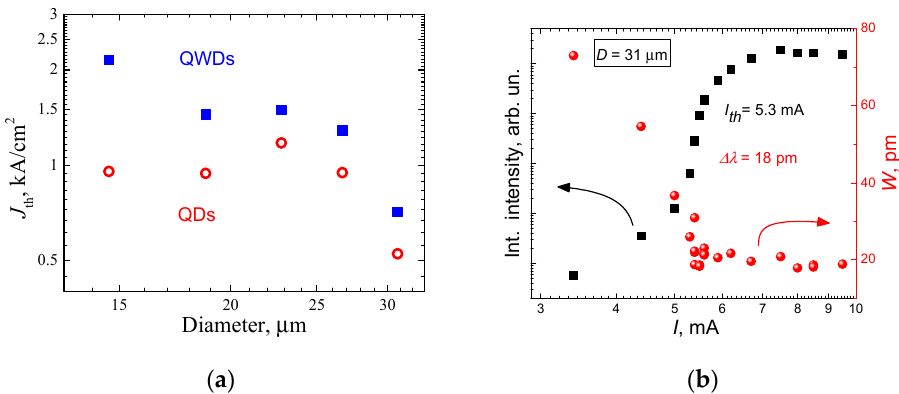
Figure 18. Threshold current of QWD (circles) and QD (squares) MD lasers as a function of diameter ( a ). Current dependence of integrated lasing line intensity (squares) and FWHM (circles) for the 1088 nm mode of a 31 µm MD laser ( b ).